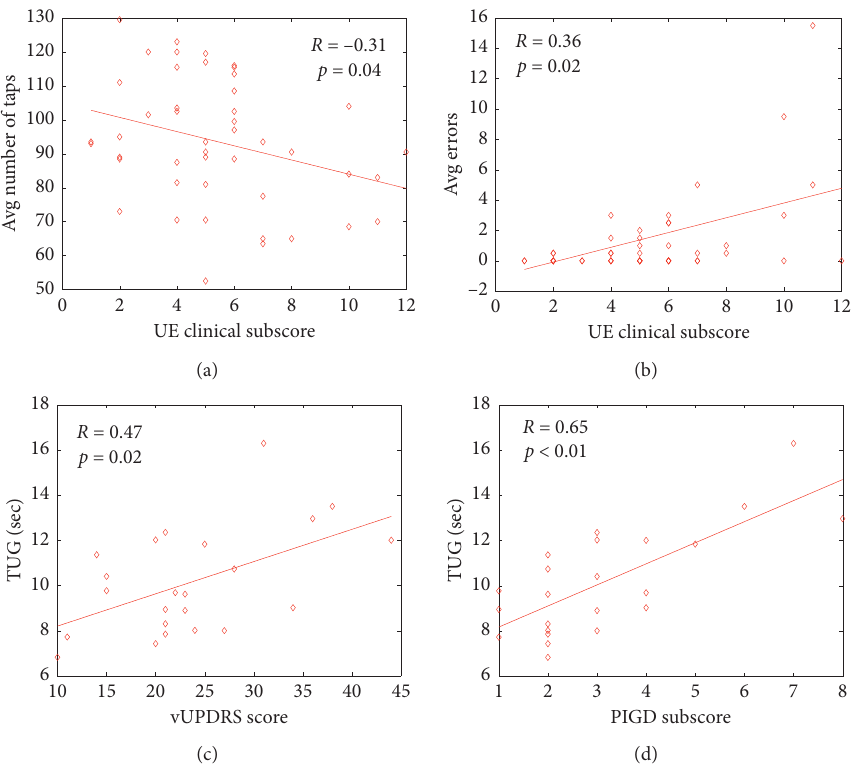
Figure 2: Finger Tapping Test measures: (a) the number of taps and (b) the number of errors were significantly related to upper extremity (UE) PD severity score measured by the vMDS-UPDRS III. Timed up and go trial times (c, d) were significantly related to total vMDS- UPDRS-III score, and clinical measures of postural and gait deficits (PIGD) measured by the vMDS-UPDRS III, Spearman rank correlation analyses, p < 0 . 05 for